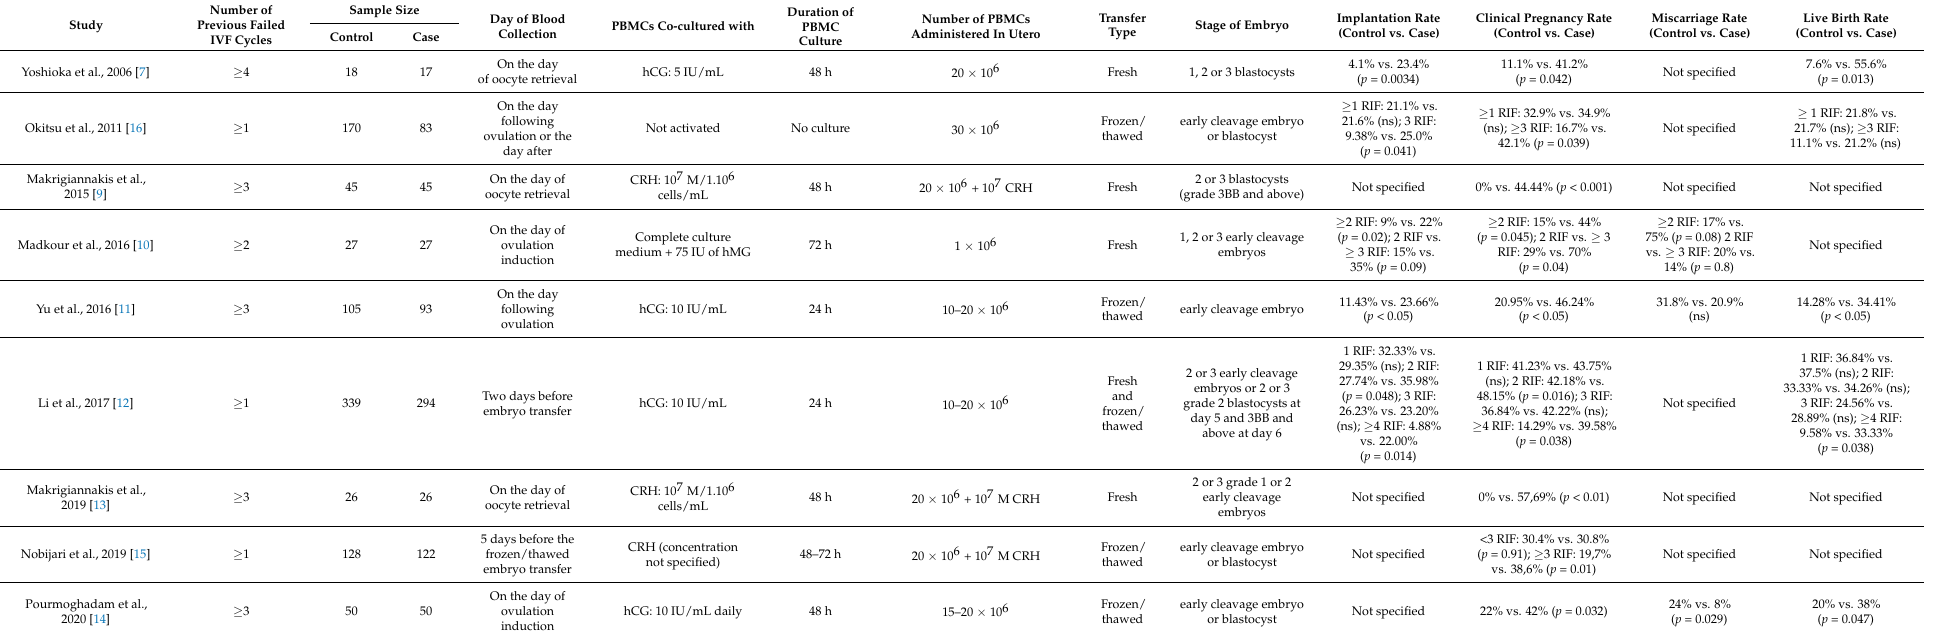
Table 1. Main studies using PBMCs to treat